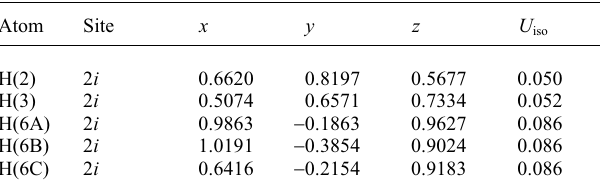
Table 2. Atomic coordinates and displacement parameters (in Å 2 )